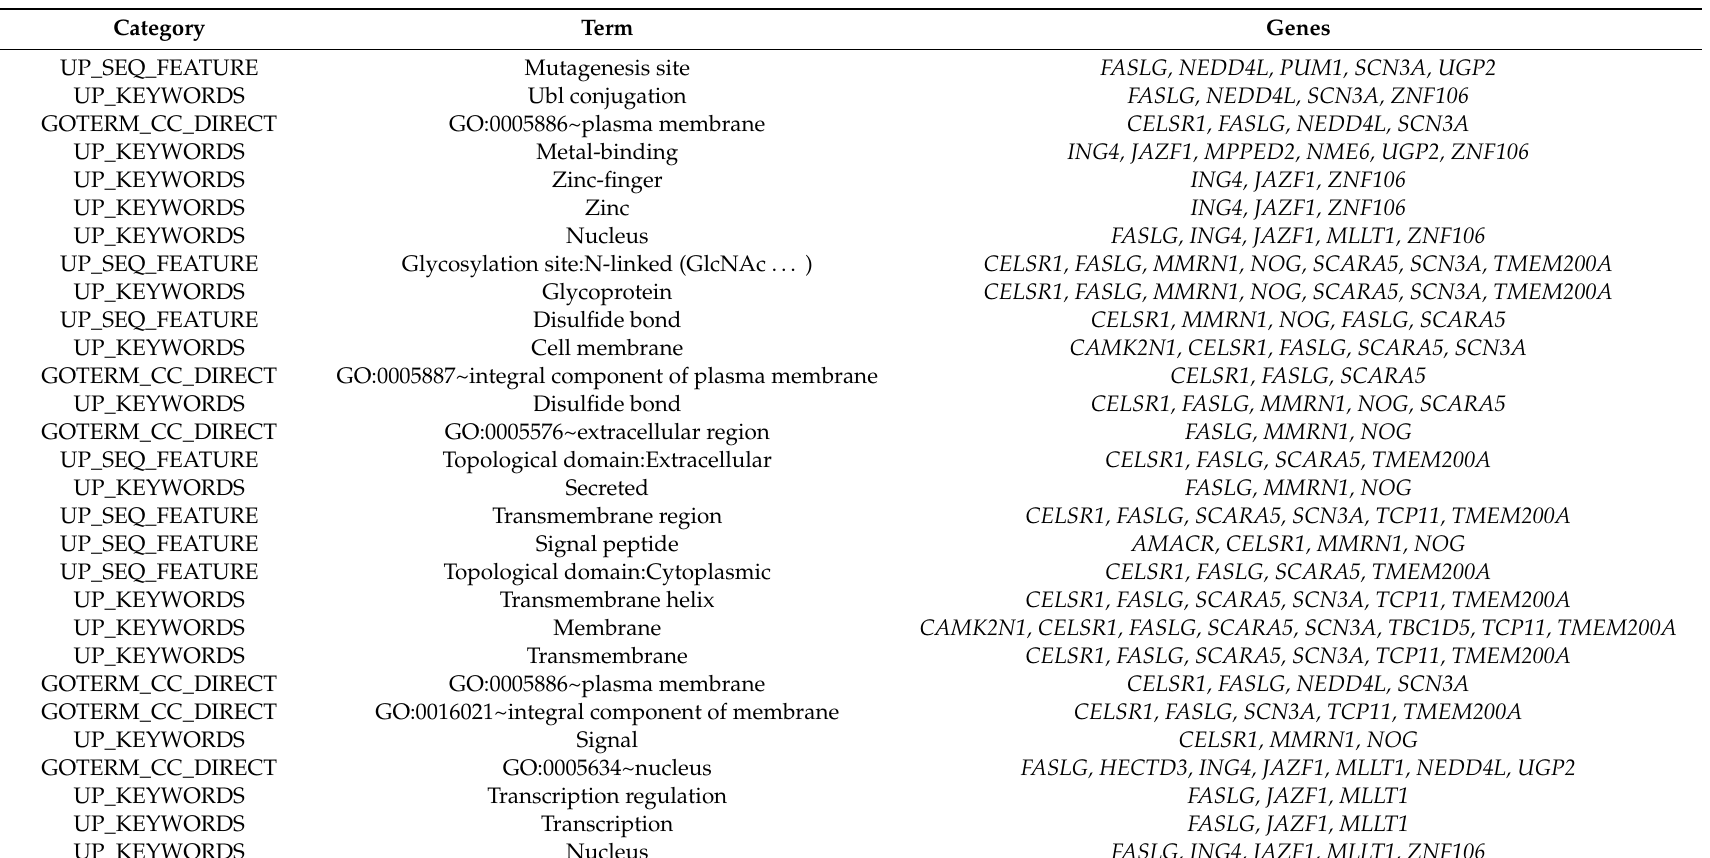
Table 3. Functional Annotation. The functional annotation was performed using the DAVID software. Category gives the database used by the DAVID software. Term gives the functional